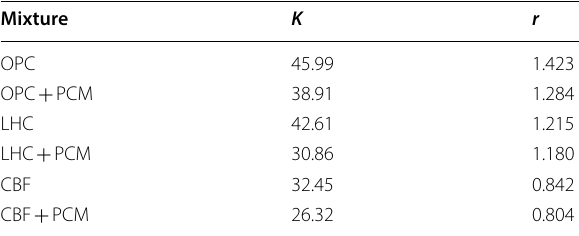
Table 4 Thermal characteristics of concrete mixtures.